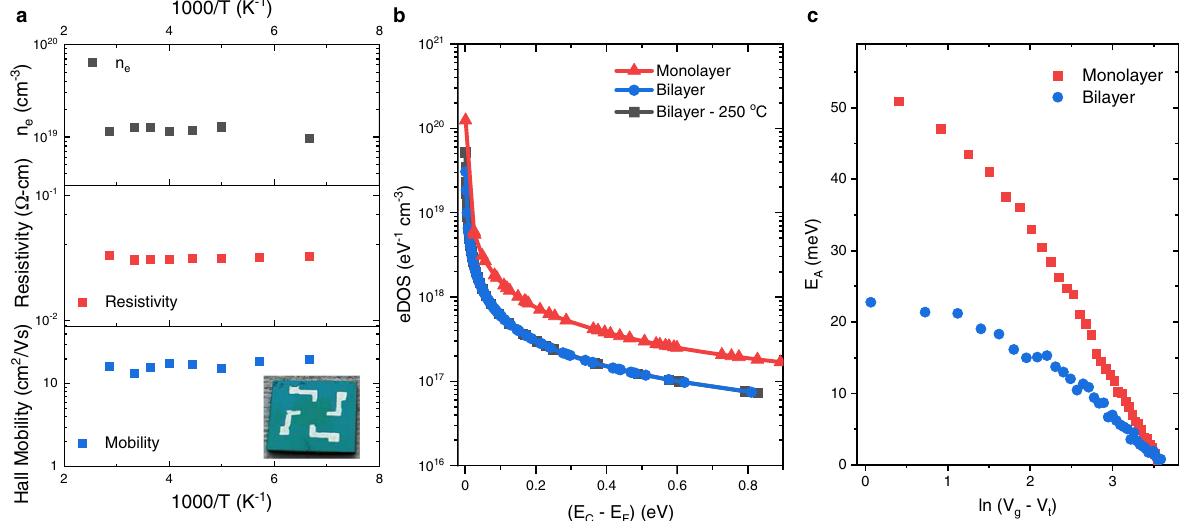
Fig. 4 Variable temperature Hall transport measurements and electronic density of states for 2D InO x . a Temperature-dependent carrier concentration, resistivity, and Hall Mobility of liquid metal printed bilayer InO x fi lms. b Measured electronic density of states (eDOS) as a function of activation energy ( E A = E C – E F ) for 2D printed InO x . c Activation energy as a function of gate voltage for bilayer and monolayer InO x